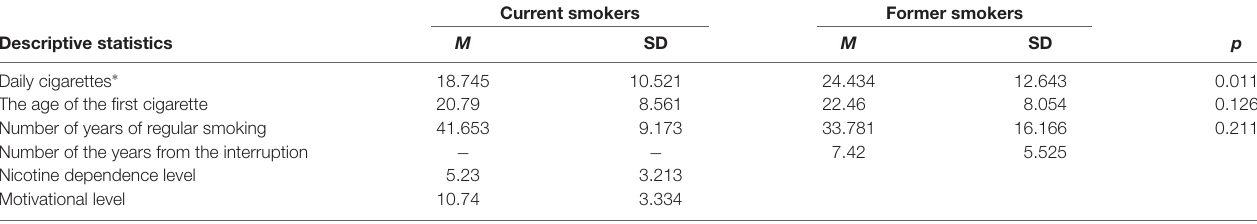
TABLE 1 | Mean standard deviation values and analysis of variance (ANOVA) p -values of participants’ characteristics.